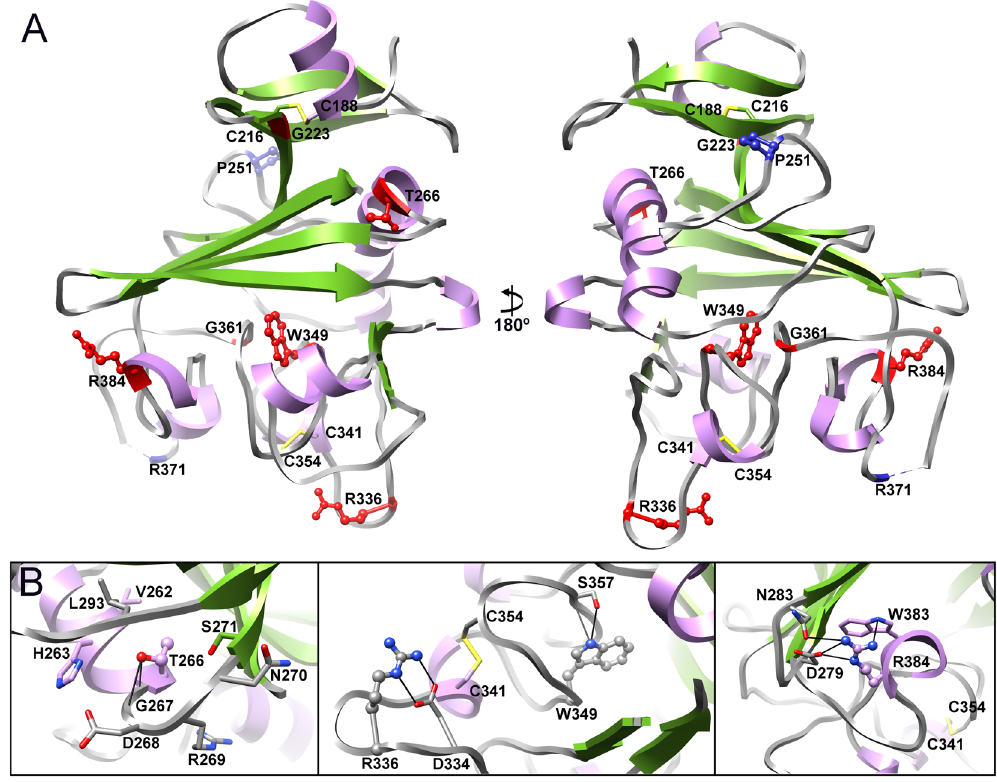
Figure 4. Structural analysis of mutations in Angptl4 which cause loss of function. ( A ) Angptl4 fibrinogen-like domain crystal structure with the sites of mutations resulting in lower triglyceride levels are indicated in red, mutations leading to the increase of triglyceride levels are shown in blue. ( B ) Close up views of the environment of the mutated amino acids in panel A. Residues are depicted and colored as in Fig.